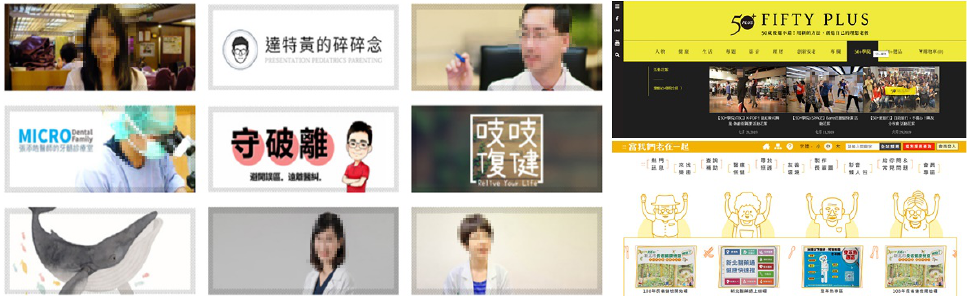
Figure 1. Analysis of existing well-known healthcare self-media.